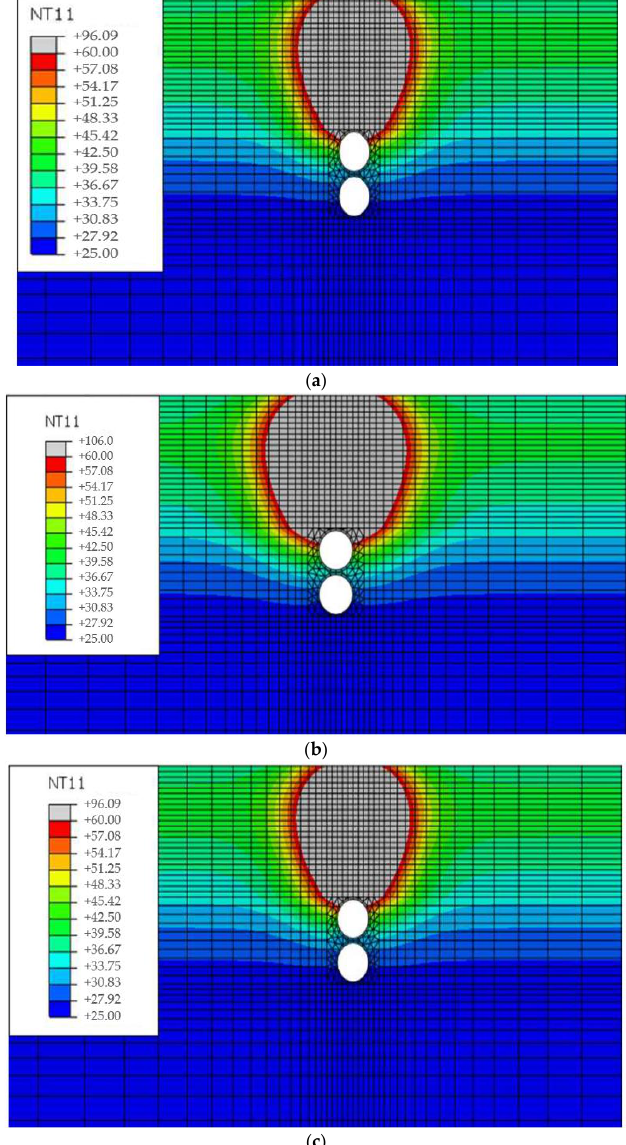
Figure 10. FE Analysis Results of Pavement Temperature Distribution. ( a ) Concrete Cover 50 mm (Warm Mix Guss Mastic Asphalt); ( b ) Concrete Cover 50 mm (Hot Mix Guss Mastic Asphalt); ( c ) Concrete Cover 100 mm (Hot Mix Guss Mastic